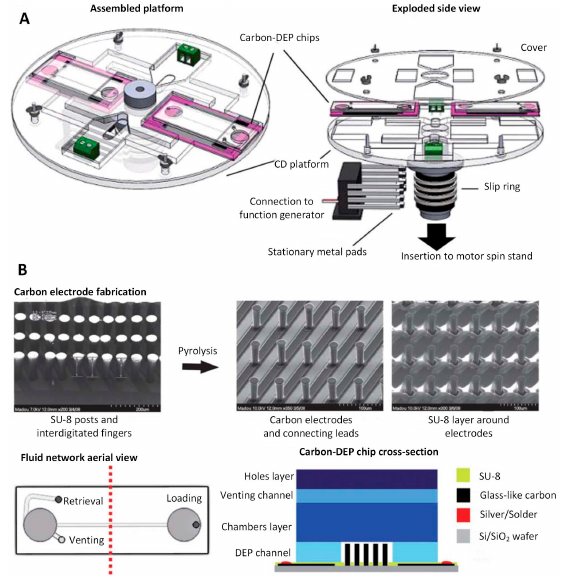
Figure 12. Compact disc (CD) microfluidic device with 3D carbon electrodes. Reproduced with permission from [91], © 2010 RSC. ( A ) Schematic of the device. ( B ) The image of the carbon electrodes and the schematic of the chip.